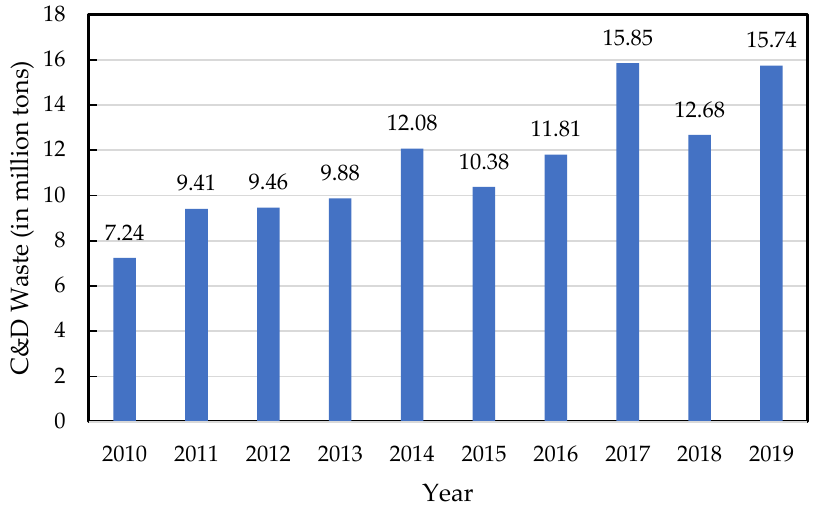
Figure 6. Quantities of C&D waste generated in Kuwait.